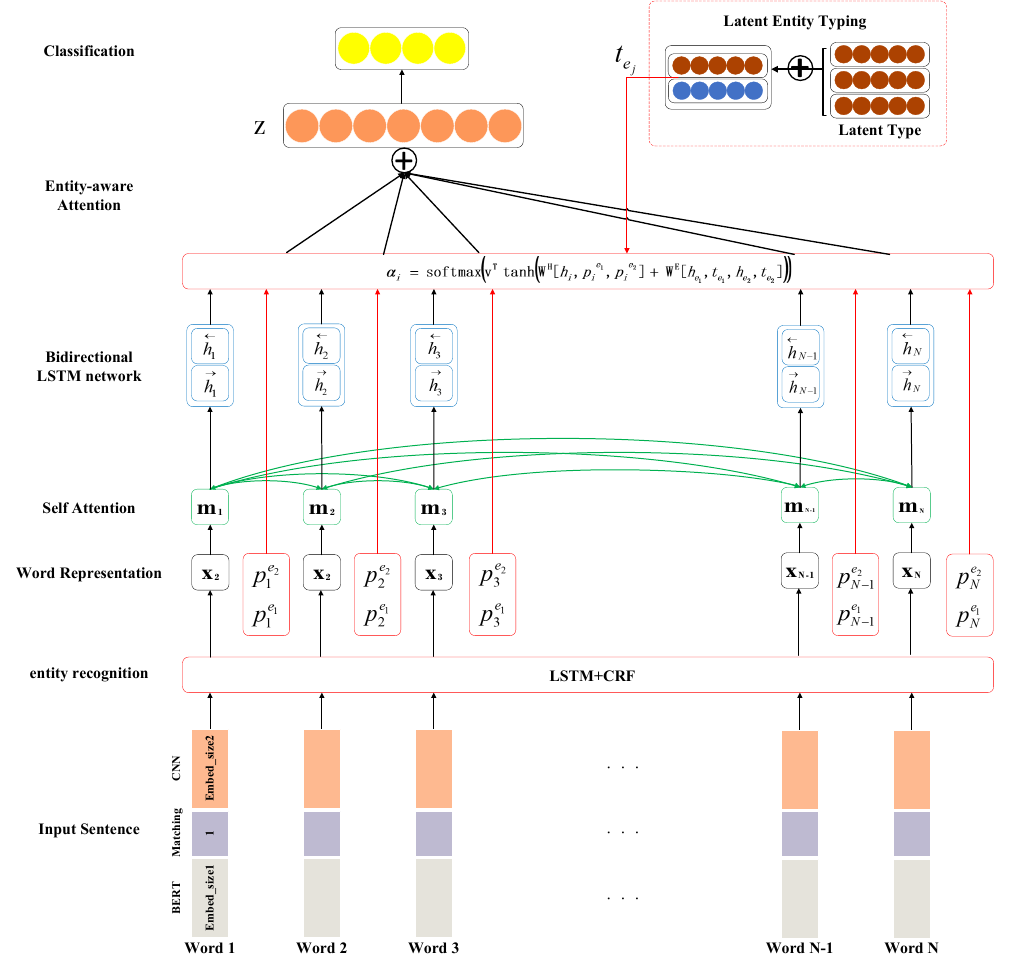
Figure 5. The architecture of our model.